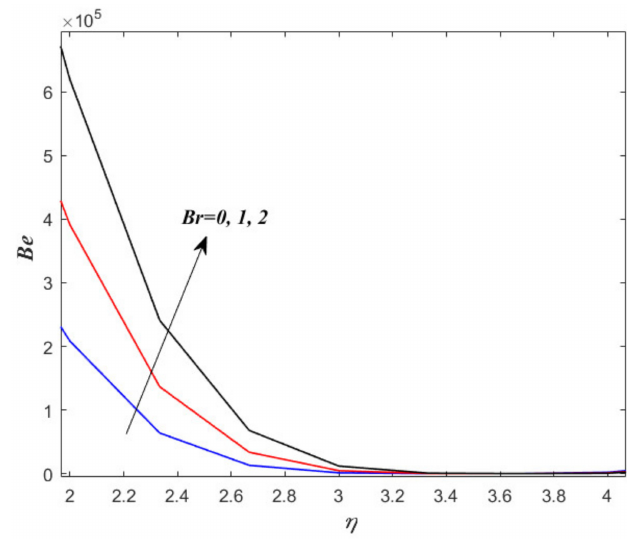
Figure 12. Various values of Brinkman number ( Br ) on Be